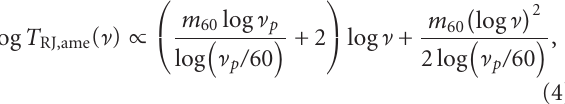
0 . 21 ( ν / 40) − 0 . 14 is the 4 )